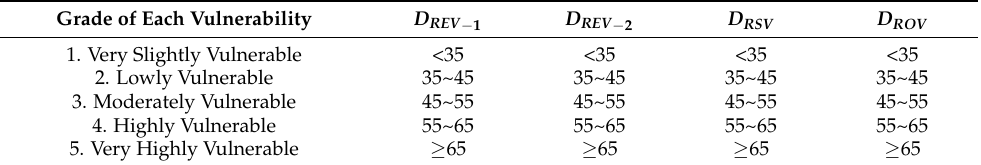
Table 4. Grading System and Standards for rural Ecological vulnerability, economic vulnerability, social vulnerability, and overall